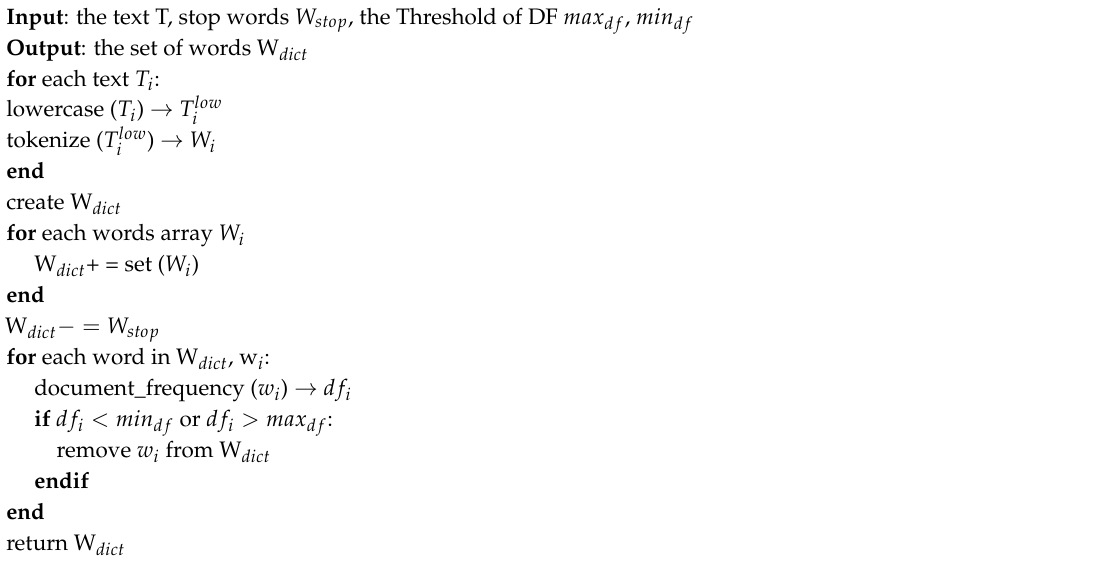
Algorithm 1 The detail process of dictionary initialization